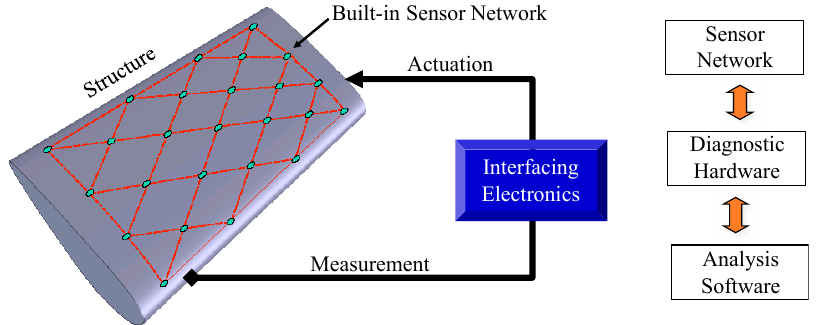
Figure 1. Composition of piezoelectric sensor network based SHM system.